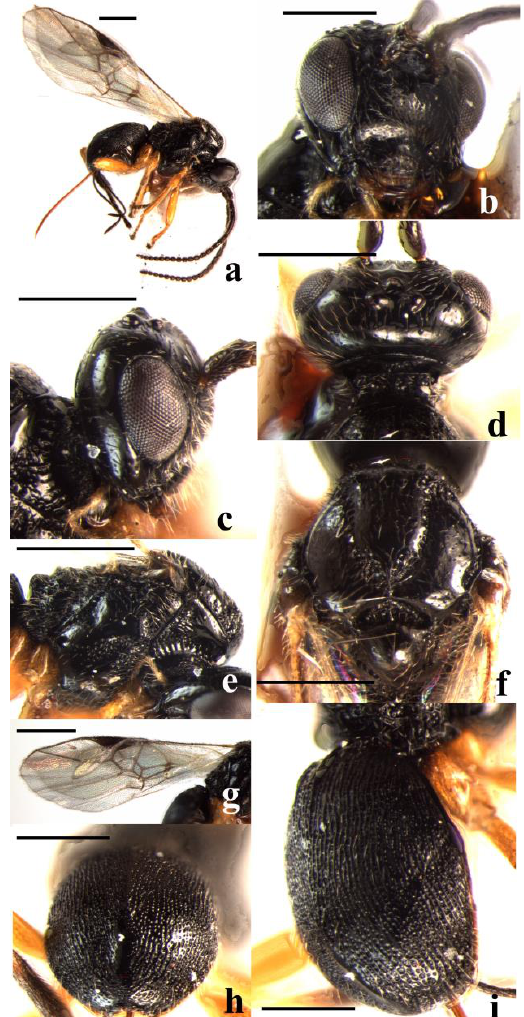
Figure 4. Schizoprymnus parvidentatus sp. nov., holotype, ♀ . ( a ) Habitus, lateral aspect; ( b ) head, latero-anterior aspect; ( c ) head, lateral aspect; ( d ) head, dorsal aspect; ( e ) mesosoma, lateral aspect; ( f ) mesoscutum, dorsal aspect; ( g ) fore wing; ( h ) third metasomal tergite apically, dorsal aspect; ( i ) carapace, latero-dorsal aspect. Scale bar: 1 mm. Mesosoma. Length of the mesosoma is 1.3 times its height. Pronope is wide and deep;